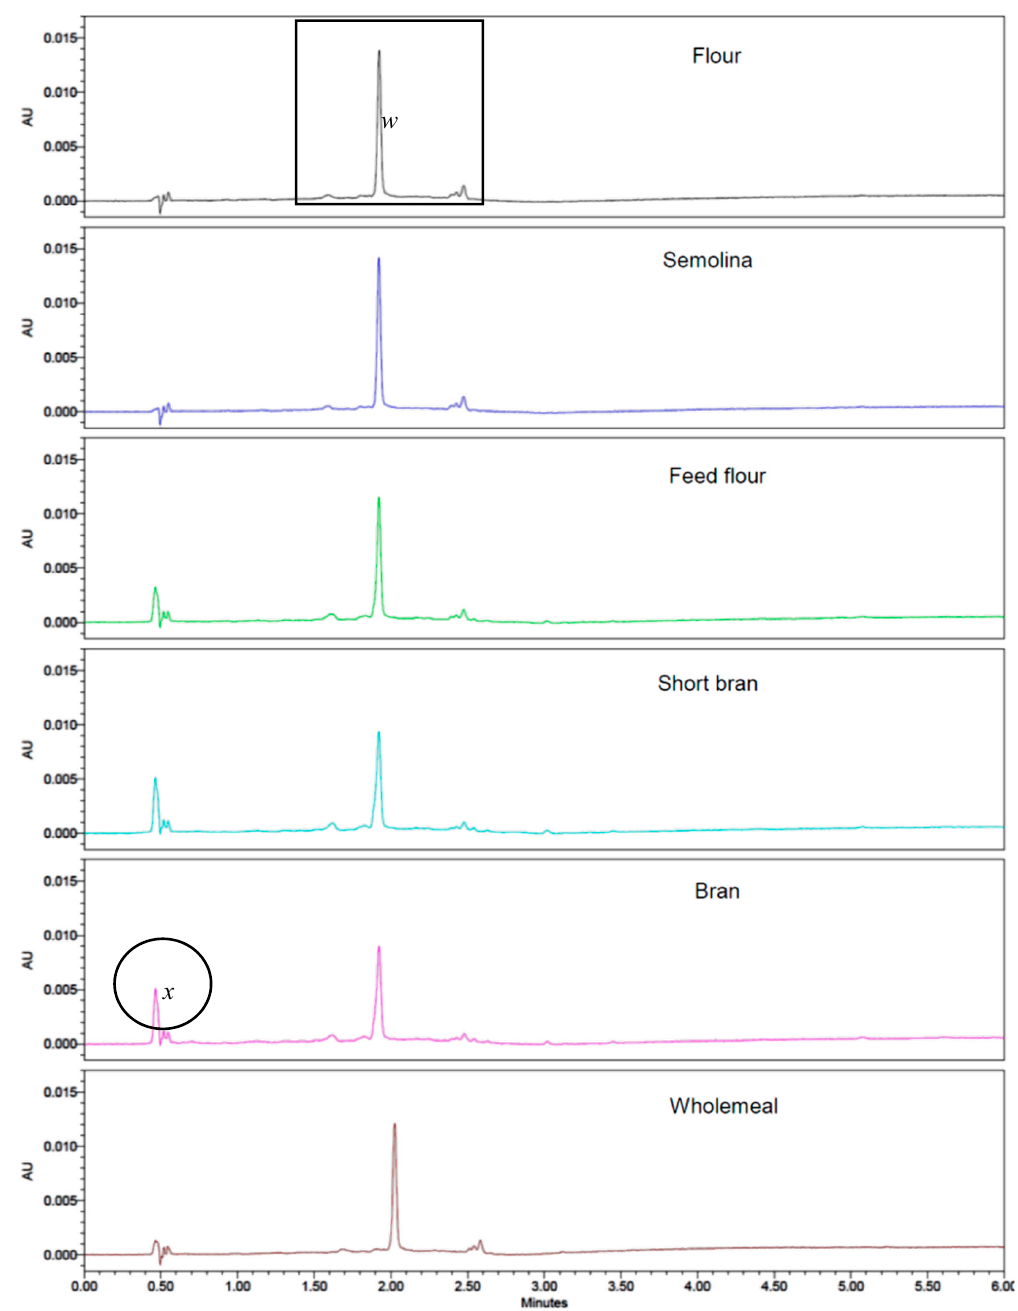
Figure 3. Ultra-performance liquid chromatography (UPLC) chromatograms of flour, semolina, feed flour, short bran, bran, and whole wheat; x = unknown compound; w = lutein and lutein isomers. Table 2. Percentage composition of lutein in the durum wheat milling fractions excluding the unknown compounds.